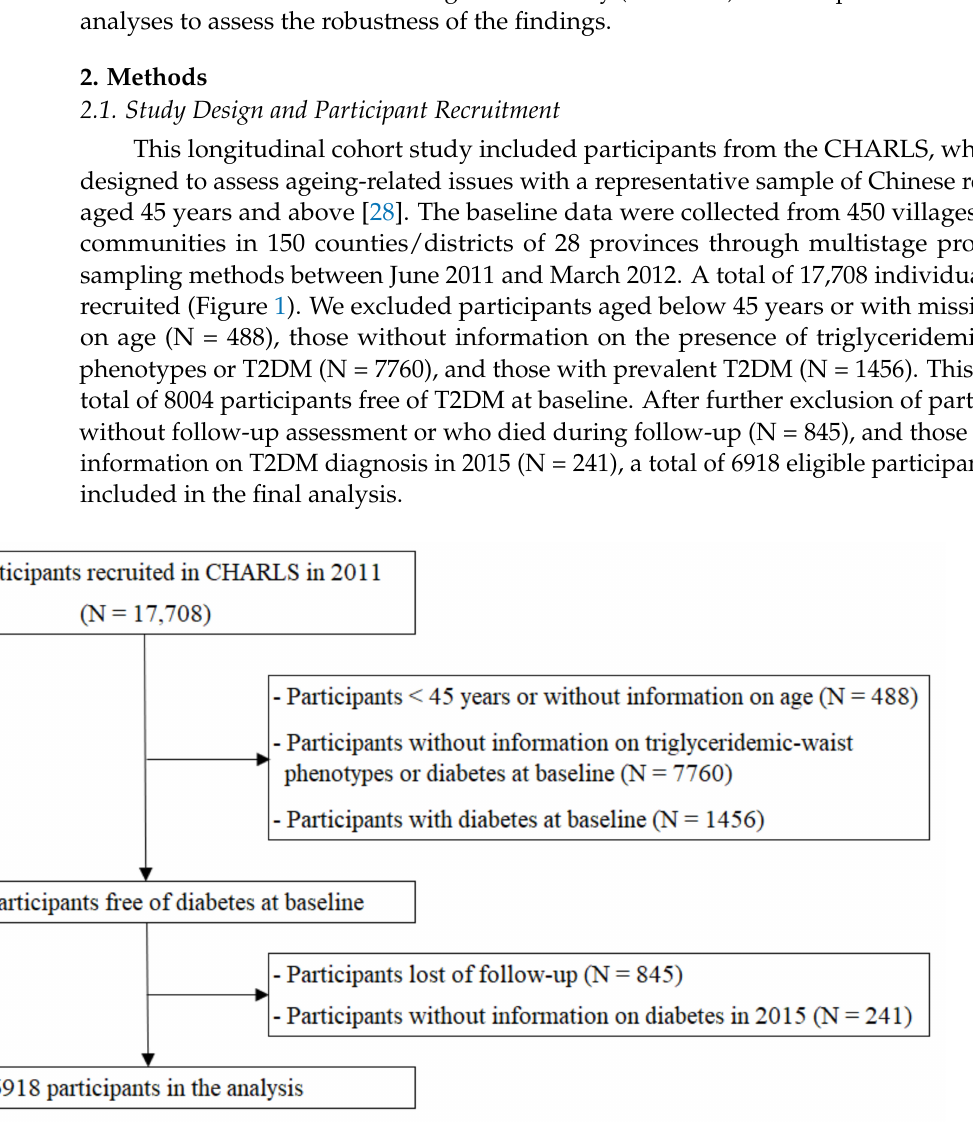
Figure 1. Flow chart of participant selection. CHARLS, China Health and Retirement Longitudinal